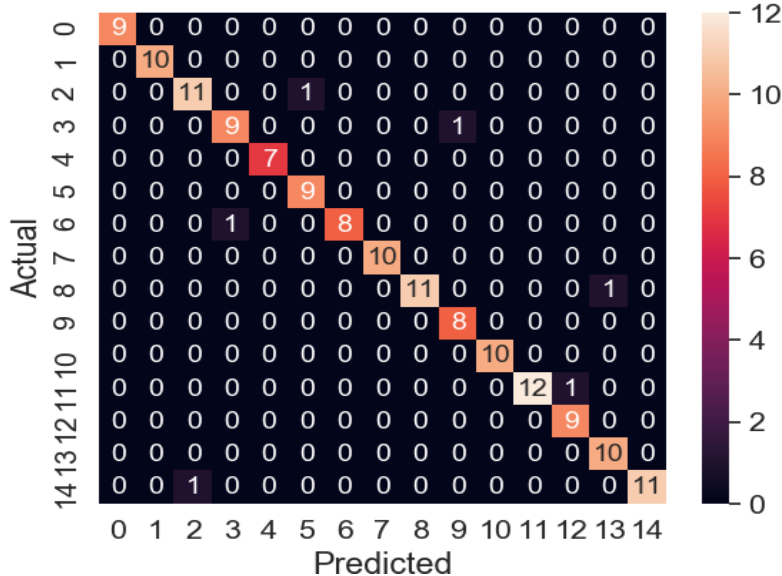
Figure 19. Confusion matrix of random forest two-factor classification results. Table 14. Overall classification accuracy